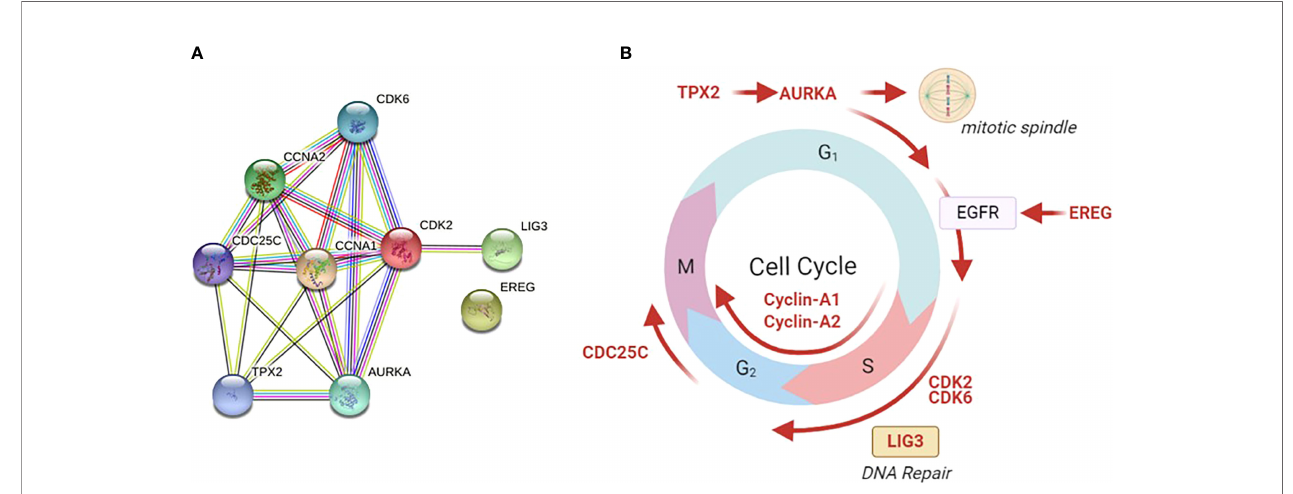
FIGURE 4 | Functional protein analysis of the most frequently shared genes among upregulated pathways in late versus early CRC stages. The analysis was performed using the STRING functional protein association network. (A) Functional protein analysis was performed for the most frequently shared kinases appearing twice in upregulated pathways in late versus early CRC stages (using STRING functional protein association network). TPX2 mediates AURKA localization to spindle microtubules. CDKs = cyclin- dependent kinases. AURKA = Aurora kinase A, EREG = Proepiregulin; Ligand of the EGF receptor/EGFR and ERBB4, LIG3 = DNA ligase 3, TGF b = Transforming growth factor beta-1, TPX2 = Targeting protein for Xklp2. (B) The site of action of each gene is shown in different phases of the cell cycle. Galanin was not linked to any of those genes in the STRING functional protein association